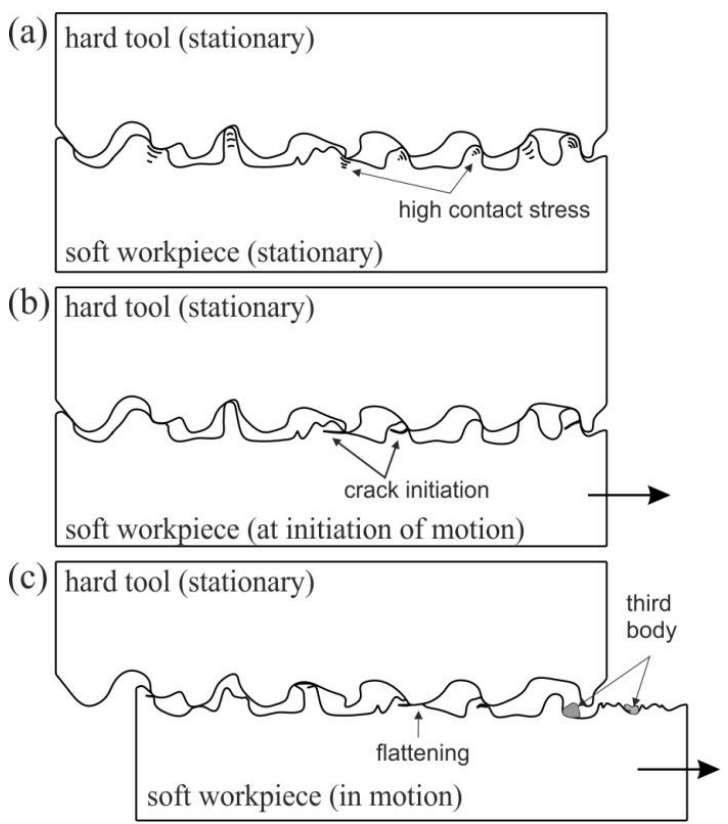
Figure 6. Character of the contact between the surfaces of the hard tool and the soft workpiece: ( a ) no movement, ( b ) initiation of motion and ( c ) in motion.